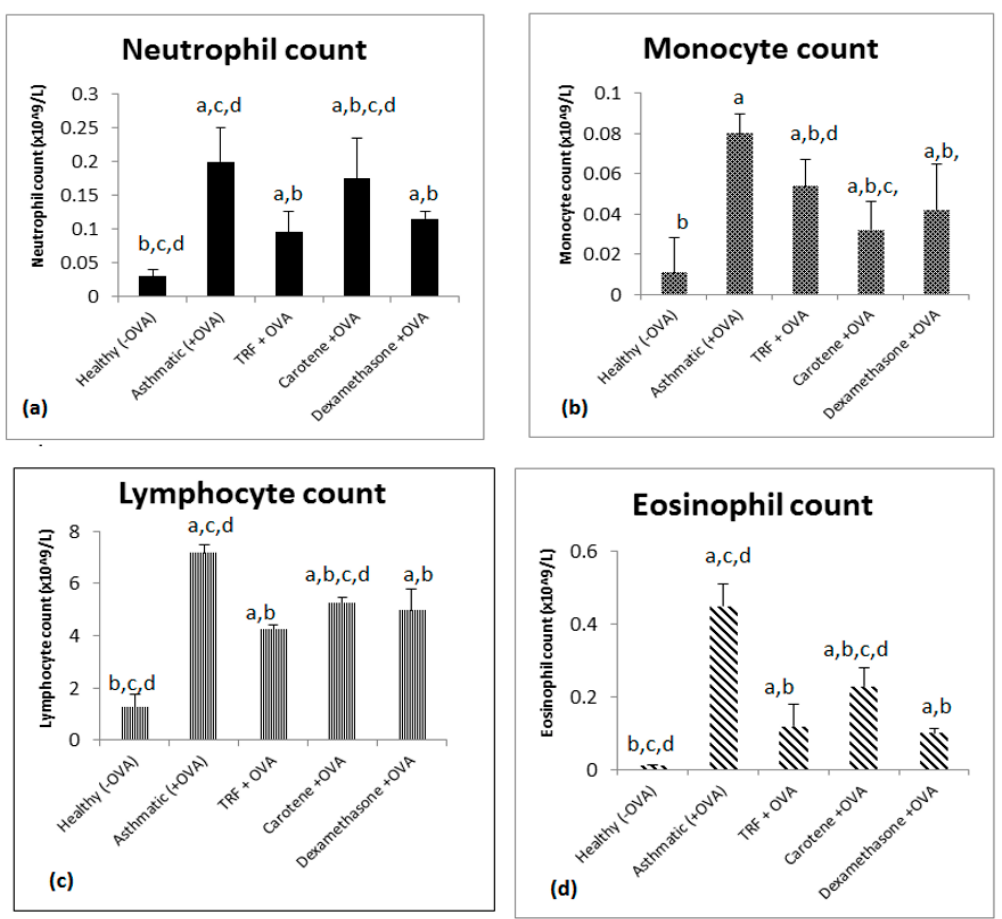
Figure 4. Effect of palm oil TRF, carotene, and dexamethasone on the total and differential cell count in whole blood of OVA-challenged asthmatic rats. The number of ( a ) total neutrophils, ( b ) lymphocytes, ( c ) monocytes, and ( d ) eosinophils from whole blood. The values are expressed as the means ± SD ( 𝑛 = 10). a P < 0.05 versus the control group. b P < 0.05, significantly different from the OVA-challenged group, c P < 0.05 versus OVA + TRF, d P < 0.05 versus OVA + dexamethasone.